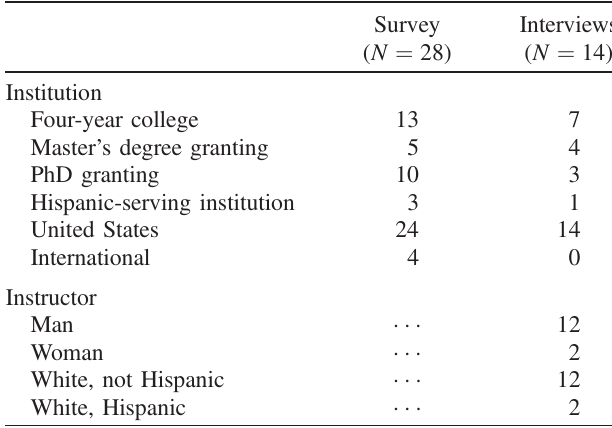
TABLE II. Types of institutions and self-reported demo- graphics of interview participants. Two of the